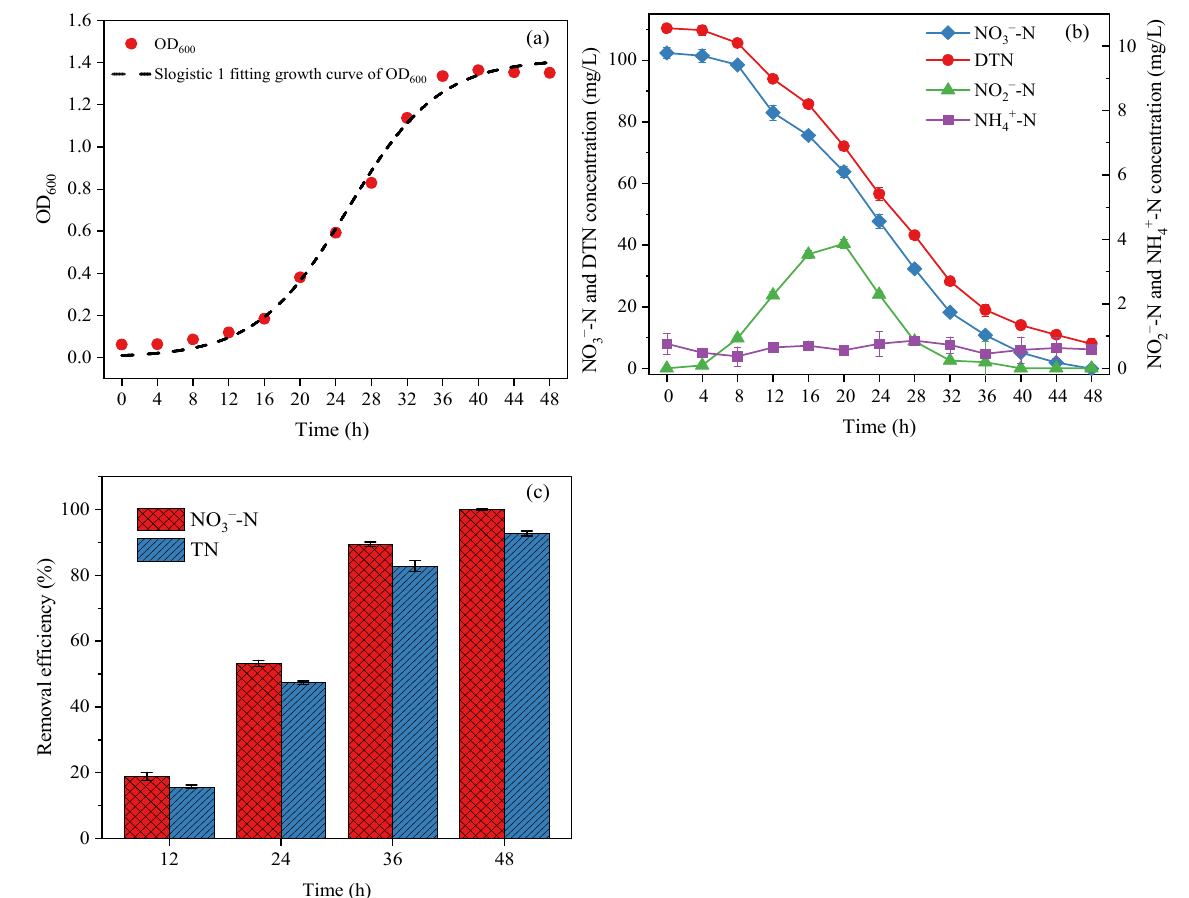
Figure 3. Nitrogen removal characteristics of strain 41: ( a ) growth curve of strain 41; ( b ) concentra- tion changes of NO 3 − -N, NO 2 − -N, NH 4+ -N and DTN of strain 41 at 15 °C; ( c ) NO 3 − -N and DTN re- moval efficiency at 15 °C.